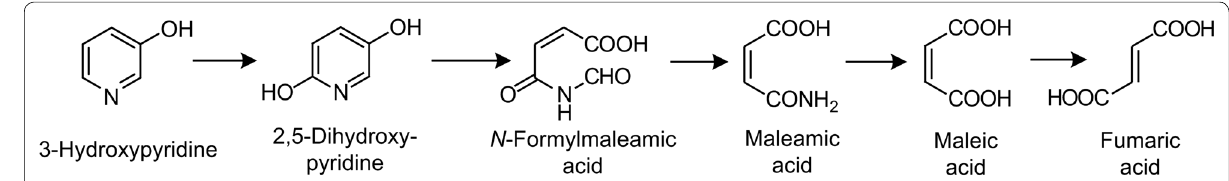
Fig. 8 Proposed 3-hydroxypyridine degradation pathway in Agrobacterium sp. strain